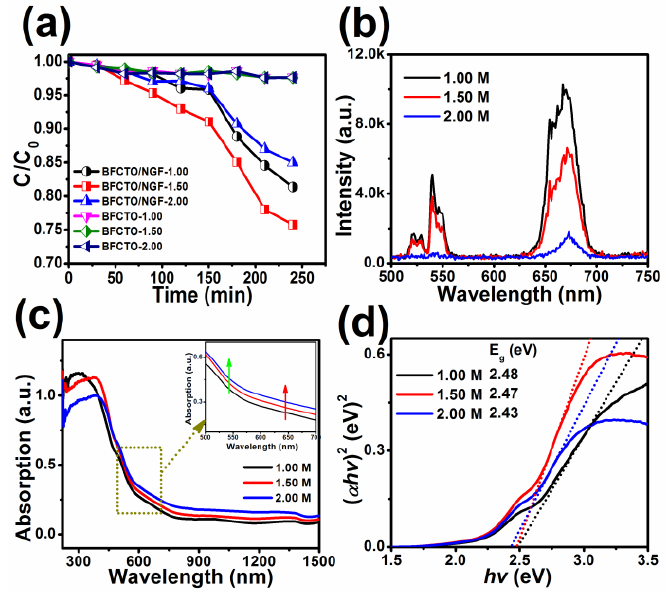
Figure 6. ( a )The irradiation time dependence of Rhodamine B (RhB) degradation in various BFCTO Figure 6. ( a ) The irradiation time dependence of Rhodamine B (RhB) degradation in various and BFCTO/NGF aqueous dispersions under near-infrared (NIR) irradiation of 980nm, with a power of 1.0A; ( b ) the upconversion emission spectra of BFCTO/NGF nanoparticles excited at 980nm; ( c ) the ultraviolet-visible-near-infrared (UV-Vis-NIR) diffuse reflectance spectra of BFCTO/NGF nanoparticles (insert: the absorption magnification of yellow dot area); ( d ) the relationship between ( α hv ) 2 and ( hv ) photon energy of all BFCTO/NGF nanoparticles (insert: Corresponding E g values).